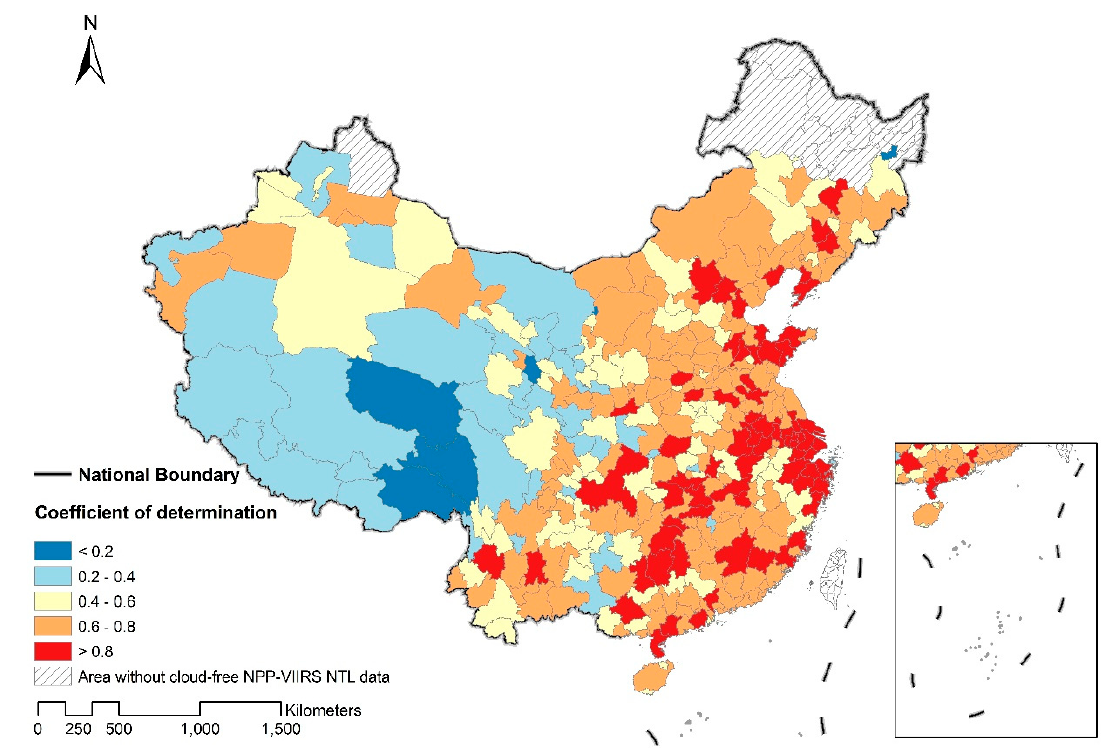
Figure 4. Spatial distribution of SSUDC coefficient of determination (R 2 ) values in Mainland China.